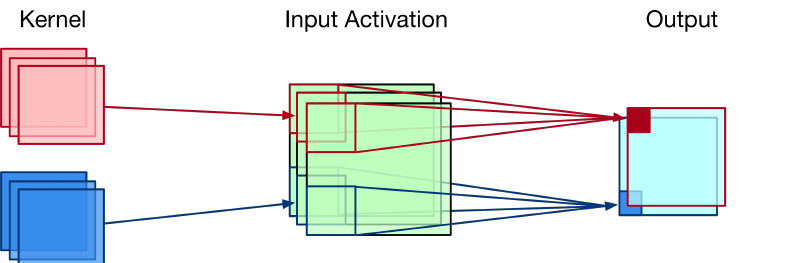
Figure 1. An illustration for the 2-D convolution. Adapted with permission from Ref [13] Copyright 2020